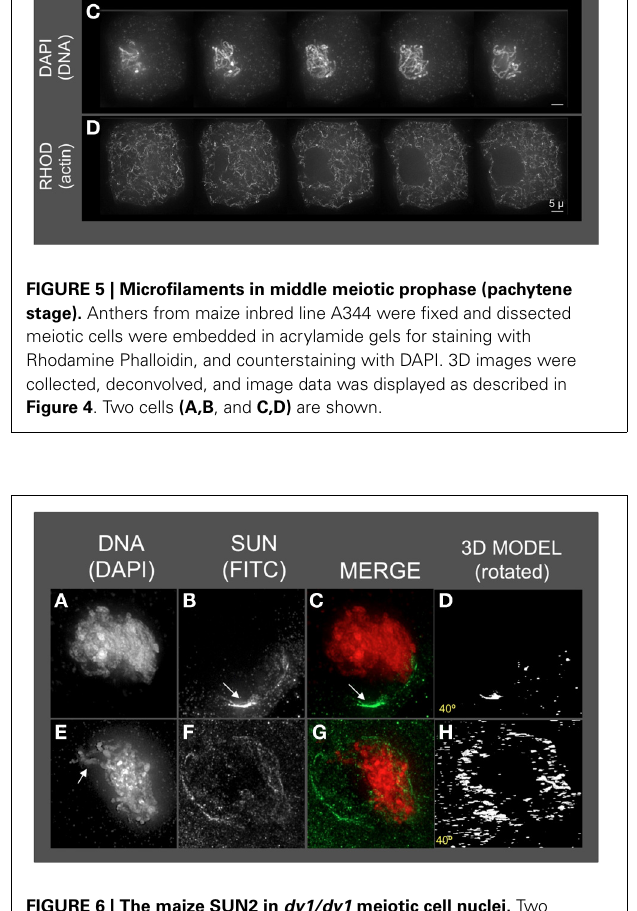
FIGURE 6 | The maize SUN2 in dy1/dy1 meiotic cell nuclei. Two representative nuclei (A–D , E–H) from cells fixed and stained as described in the legend for Figure 2 . DAPI (total DNA, red) and FITC (SUN, green) images are shown along with projections/3D models of the FITC images viewed as rotations about the Y axis (D,H) . A bright patch of SUN staining (arrow, panels B,C ) near the nucleolus (arrow in B ) and a thick pachytene-like fiber (arrow in E ) is indicated. Scale bars = 5 μ m.